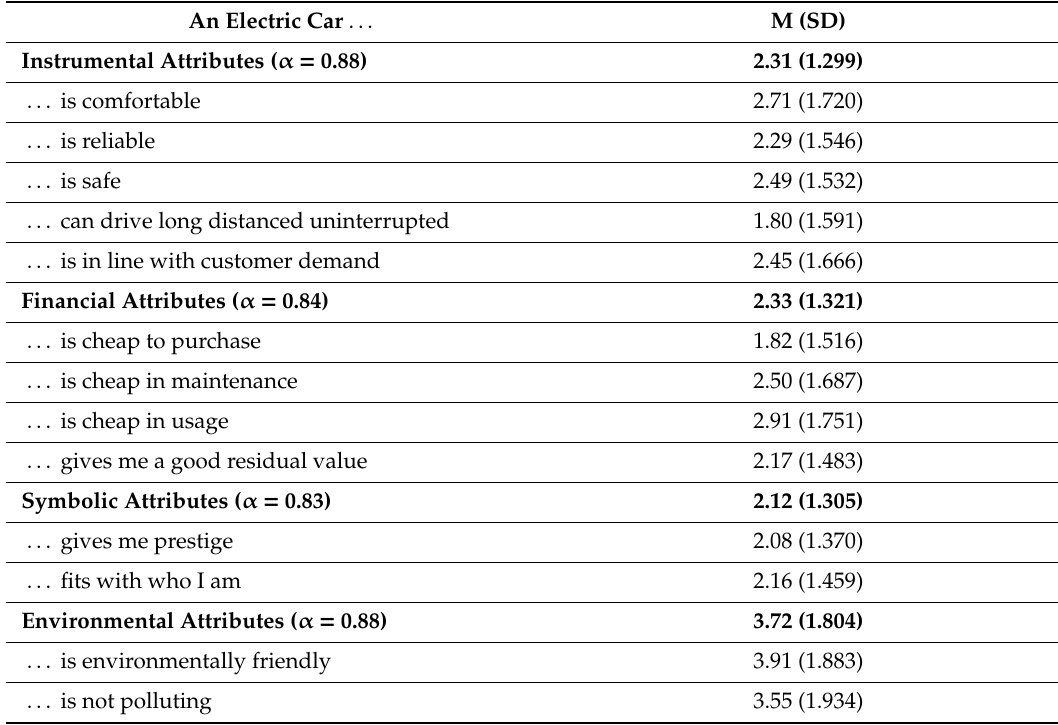
Table 2. Attribute items and